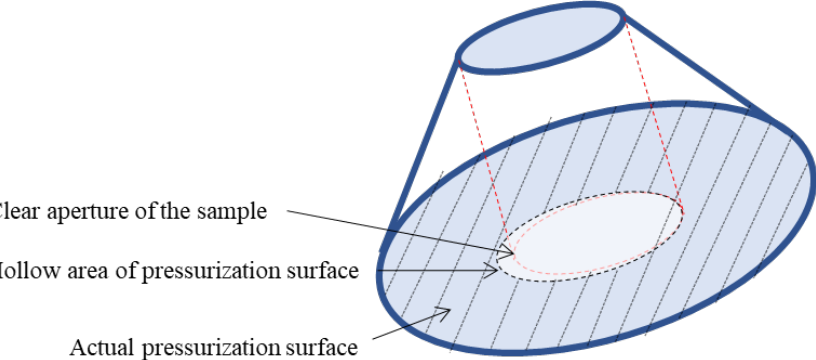
Figure 9. Relationship of the clear aperture of the sample with the pressurization surface.